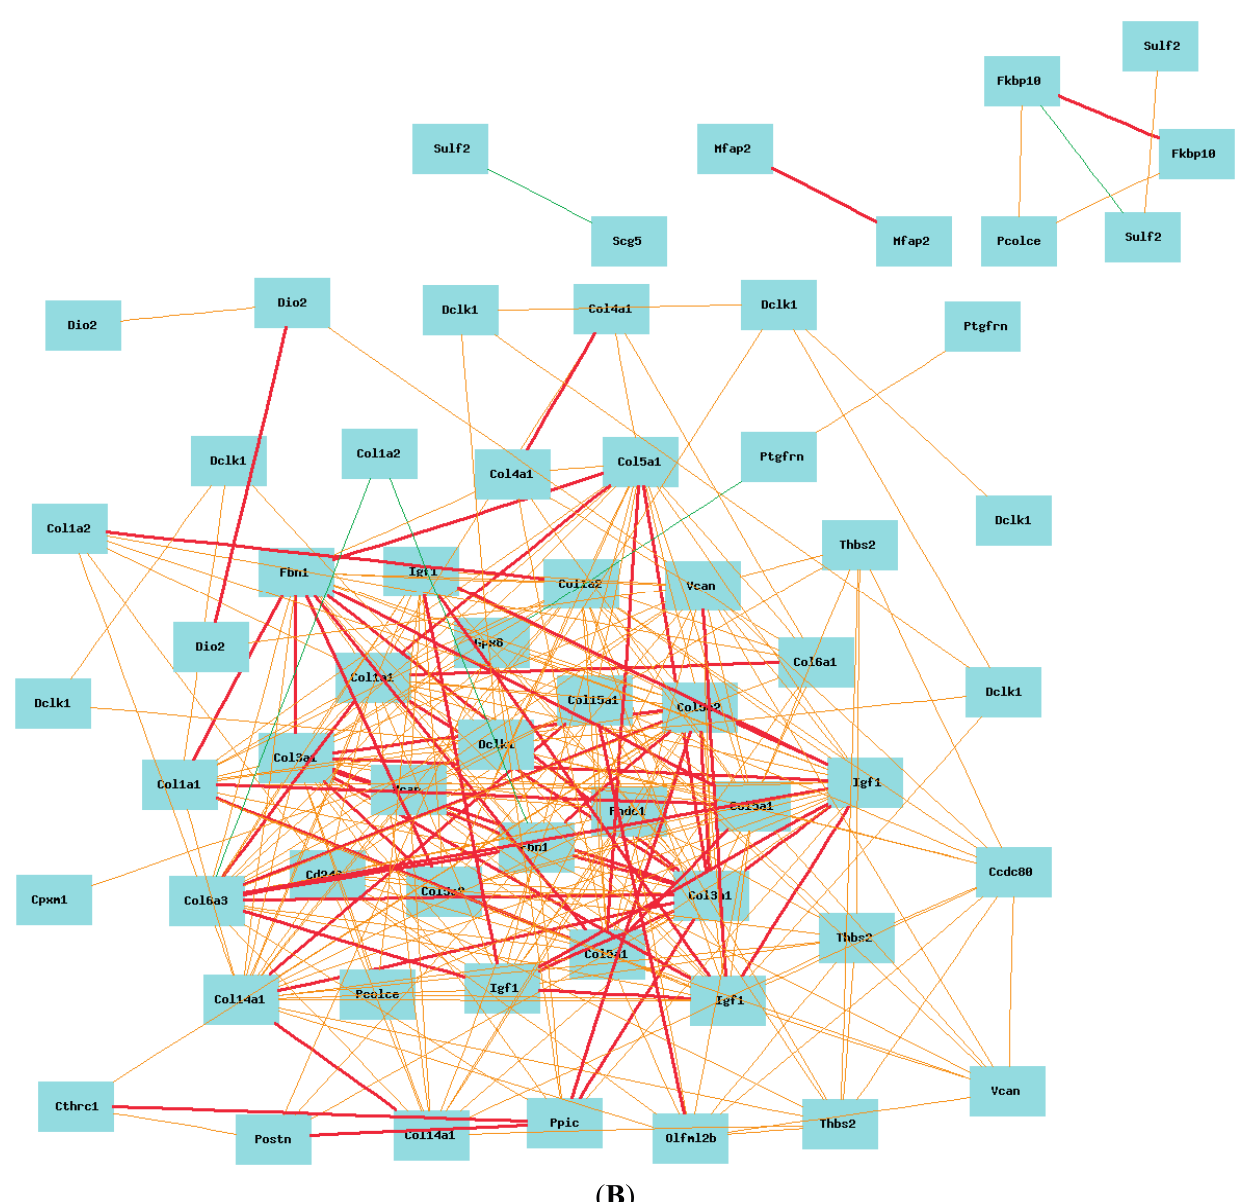
Figure 6. Gene networks of common genes in mice and humans. Each subfigure shows Pearson correlation coefficients greater than 0.5 or less than − 0.5. The graph’s canvas is 40.0 by 40.0 cm, and the node labels are drawn with a 14.0 point font, and the edge labels are drawn with a 14.0 point font. ( A ) Gene network of 41 common genes and COL3A1 in human lung with probe 100149328. The 42 nodes in the graph below show the selected traits. All nodes are displayed. The 566 edges between the nodes, filtered from the 861 total edges and drawn as curves; ( B ) Correlations between the 41 common top human genes with Col3a1 in mouse lung. The 89 nodes in the graph below show the selected traits. Only nodes with edges are displayed. The 289 edges between the nodes were filtered from the 3916 total edges and drawn as